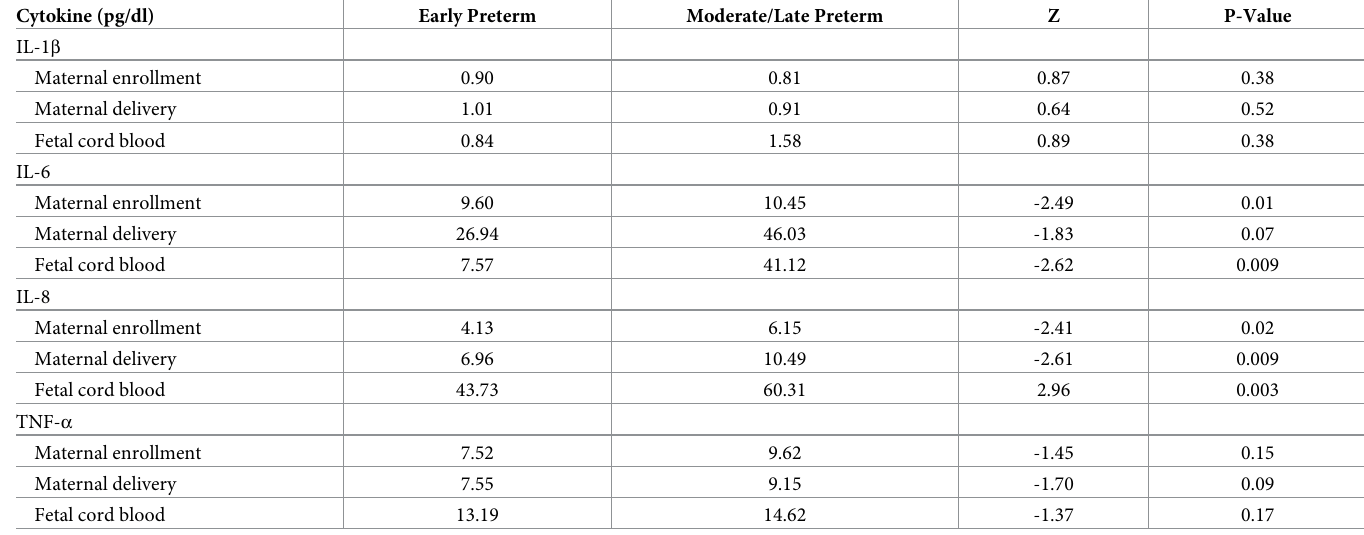
chronic villitis and none showed evidence of fetal inflammatory response. Maternal vascular malperfusion was seen in 22 placentas, and were much more frequent in the early preterm group (p = 0.004). Four subjects (6%) with placental maternal malperfusion had moderate- severe PSOM score, which was not significantly different from those without maternal malper- fusion (p = 0.65). There was evidence of fetal malperfusion in only three placentas (4%); none of these were associated with a moderate-severe PSOM score. Seven infants (11%) without evi- dence of placental inflammation scored moderate-severe at 6-month PSOM. Given the small numbers, statistical analysis between cytokine elevation and placental pathologies could not be performed, although patterns did emerge. For instance, when chronic villitis was present (N = 5), higher maternal levels of IL-6 (N = 3; 60%) were usually present rather than in fetal cord blood. Although only 3 cases of histologic fetal inflammatory response were seen, both IL-6 and IL-8 were elevated in the fetal cord blood (N = 2; 67%), but not ele- vated in maternal samples. Interestingly, when there were no histological signs of inflamma- tion (N = 56), higher levels of maternal IL-6 at enrollment (N = 17; 30%), delivery (N = 16; 29%), and fetal cord blood (N = 13; 23%) were sometimes seen; similarly, higher levels of maternal IL-8 at enrollment (N = 19; 54%), delivery (N = 18; 32%) and fetal cord blood (N = 16; 29%) were also seen. Unlike IL-6 and IL-8, there were no cases of increased IL-1 β or TNF- α and placental pathologies, nor any cases of increased IL-1 β or TNF- α when no placen- tal inflammation was present. Table 4. Mean cytokine levels at early preterm ( < 32 weeks gestational age) vs moderate/late preterm ( � 32 weeks gestational age); P < 0.05 significant. Cytokine